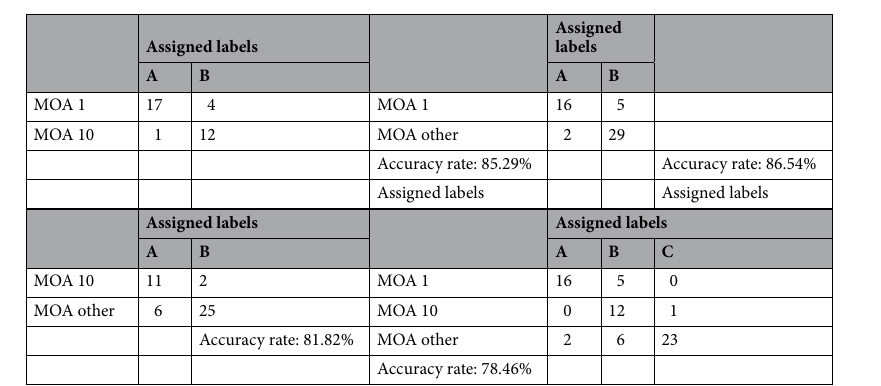
Table 4. Results of binary clustering for B-spline